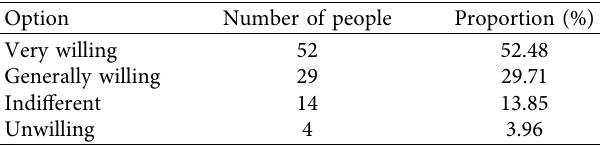
Table 3: Willingness to participate in school mental health edu- cation after